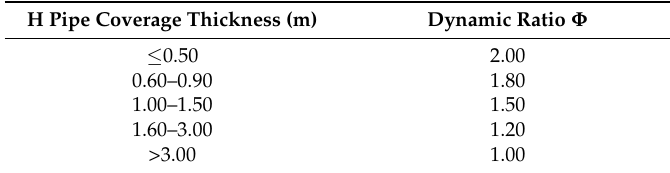
Table 5. Adopted values of the dynamic ratio Φ .